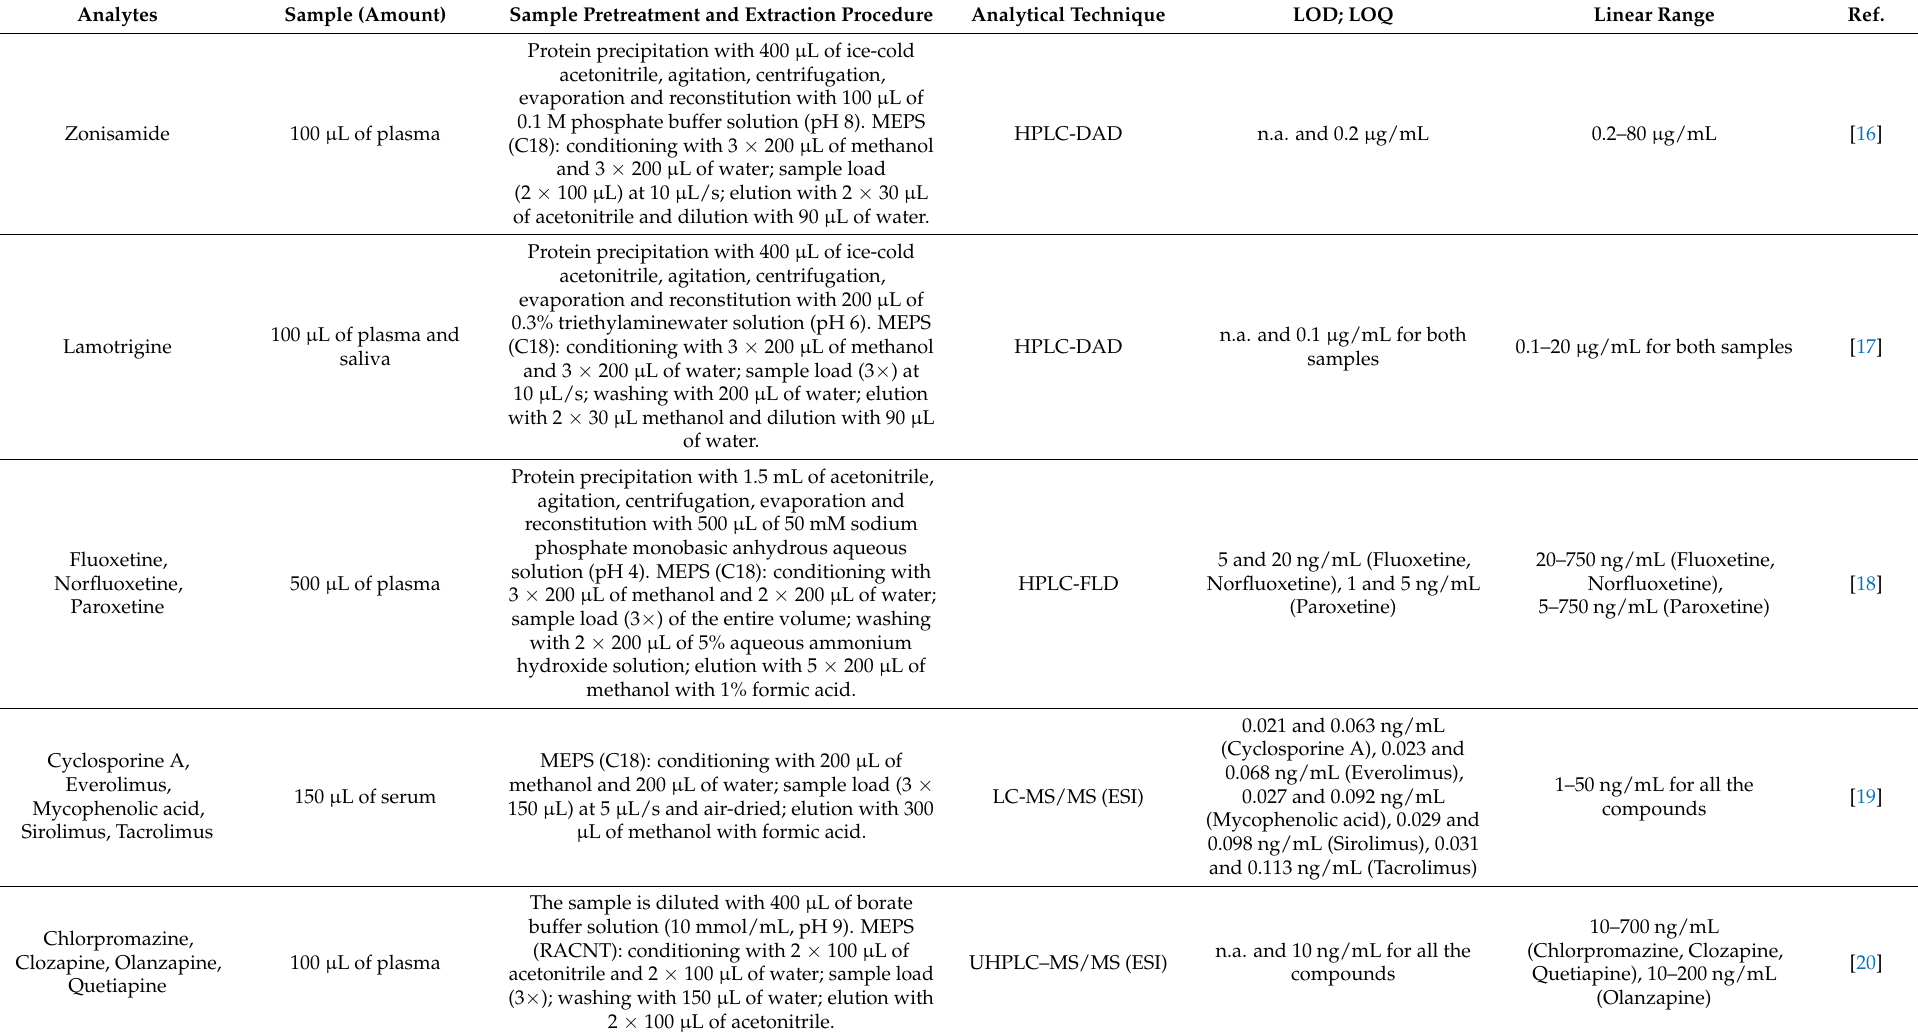
Table 2. Bioanalytical procedures using MEPS approaches for